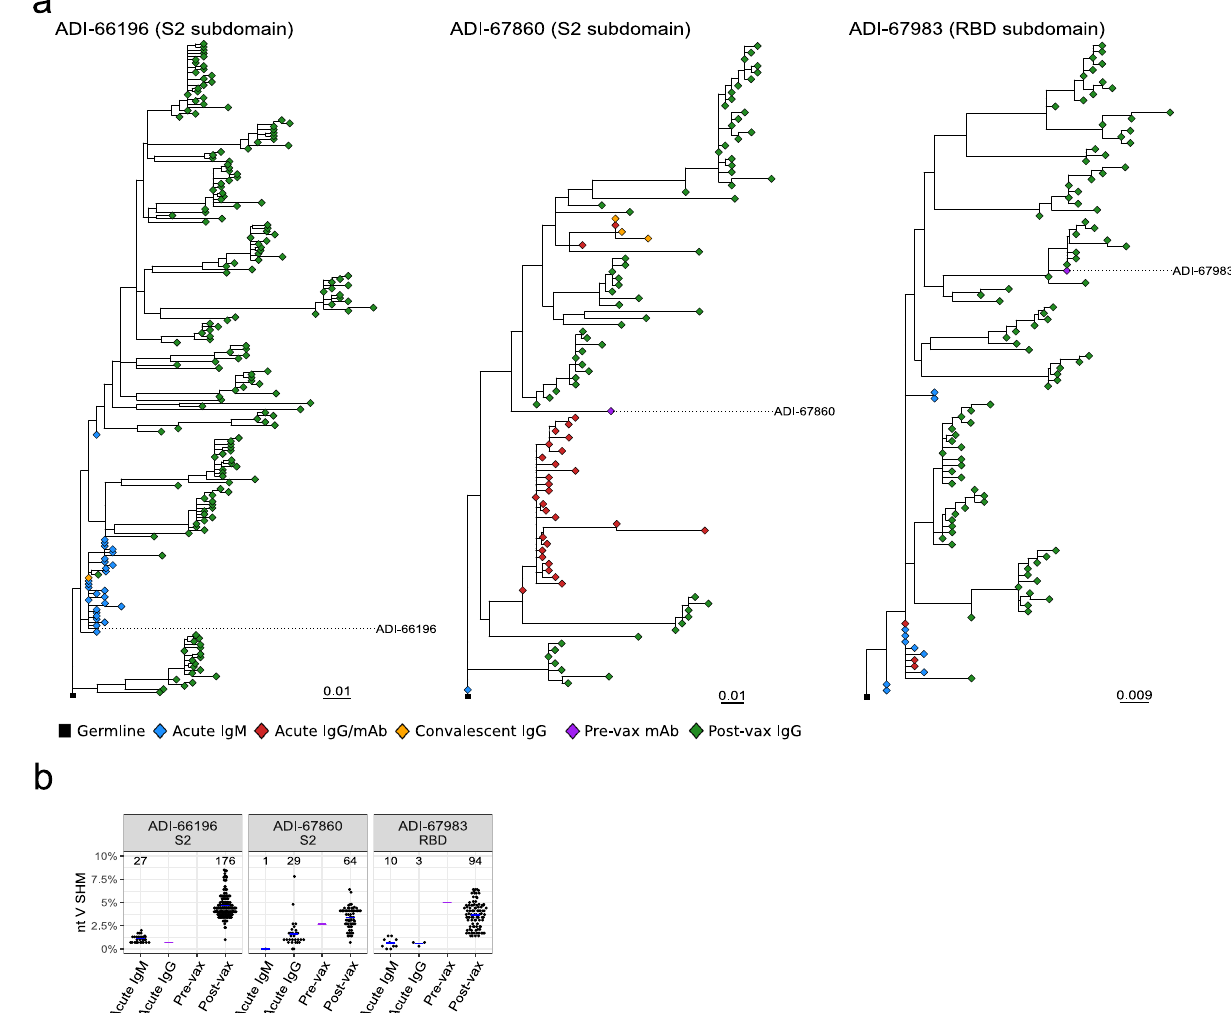
Fig.4|EvolutionofSARS-CoV-2S-speci fi cantibodylineagesoverthesampling timepoints.a Maximum-likelihoodphylogenetictreeoftracedlineagescontaining IgM Rep-seq sequences: ADI-66196, ADI-67860, and ADI-67983. Germlines sequences were obtained from the IgBLAST-generated “ germline_alignment ”